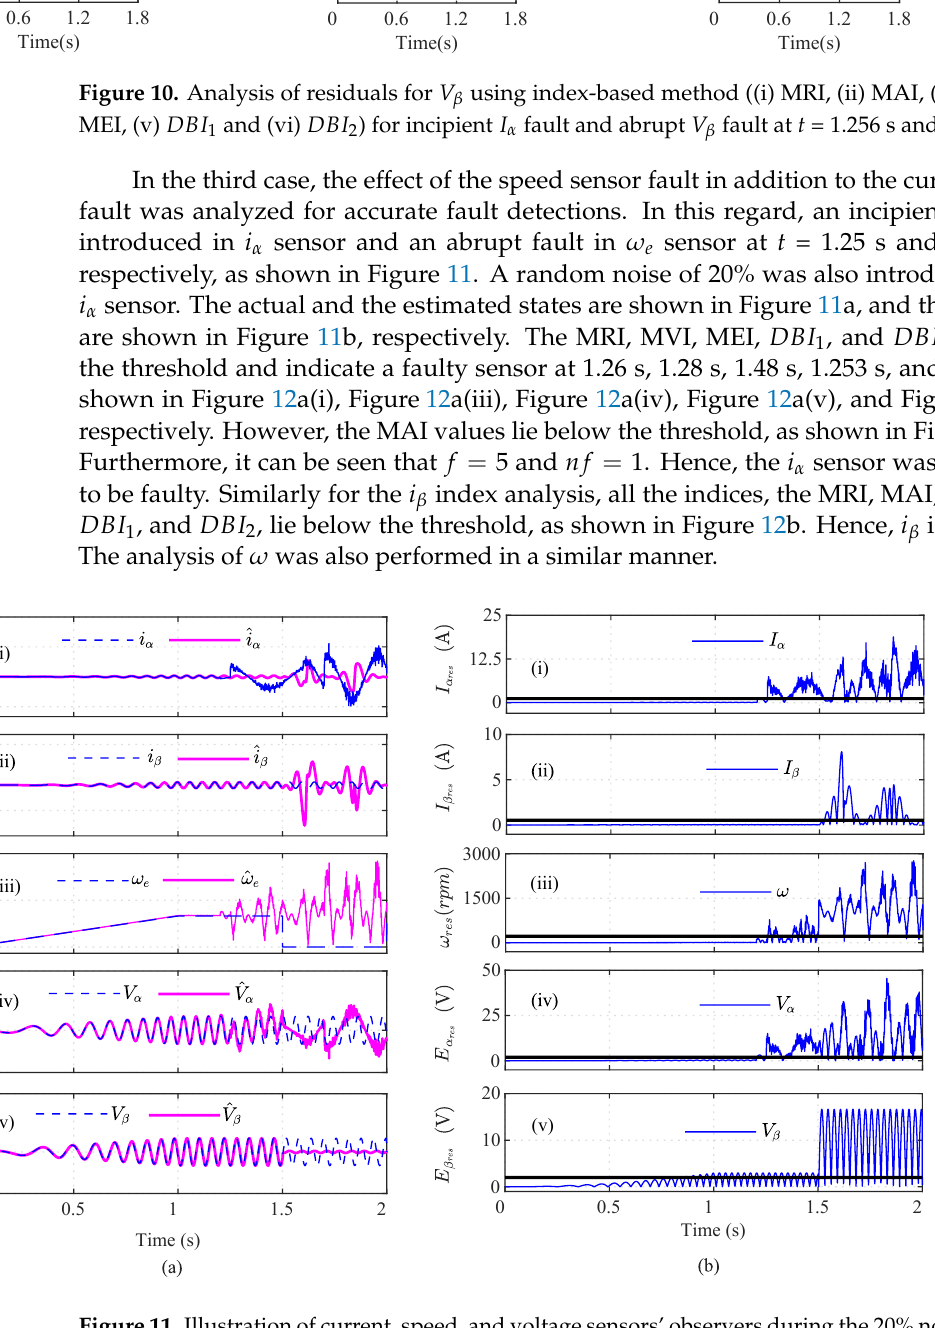
Figure 11. Illustration of current, speed, and voltage sensors’ observers during the 20% noisy incipient i α fault and abrupt W e fault scenario at t = 1.25 s and t = 1.50 s, respectively; ( a ) actual and estimated signals; ( b )